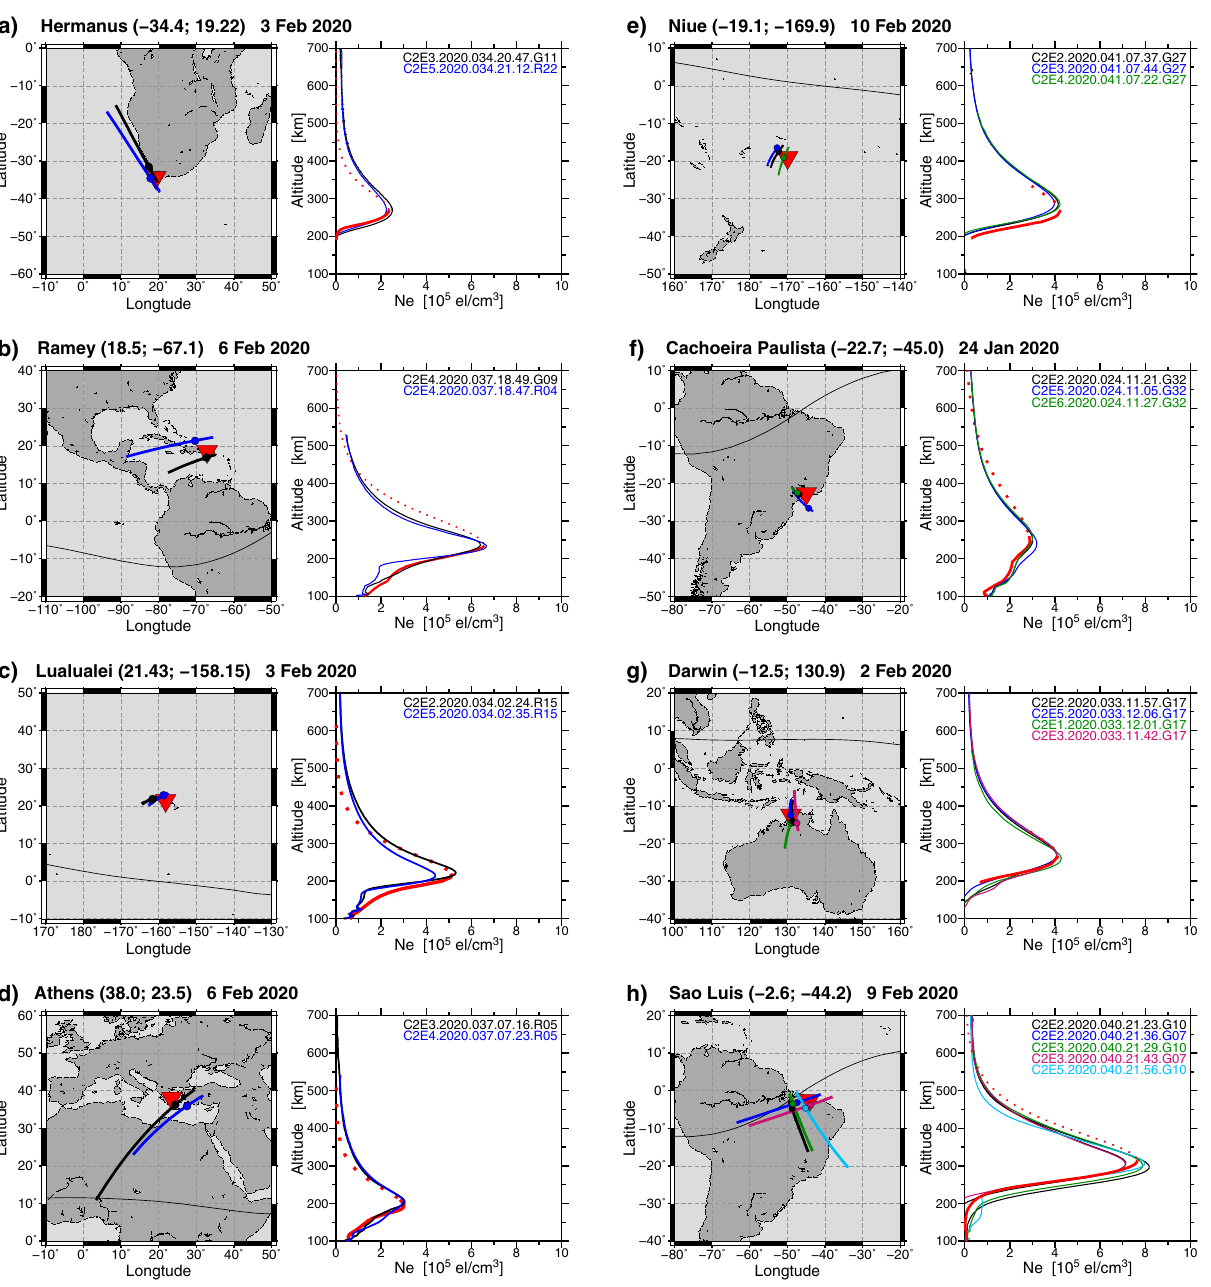
Fig. 2. (a – h) Examples of multiple COSMIC-2 RO electron density pro fi les as compared with collocated ionosondes. For each panel, left plot shows a geographical map with the ionosonde location (red triangle) and RO tangent points projection (small dots show the F2 peak point location on the trace), black line depicts the magnetic equator; right plot shows RO-derived Ne pro fi les and ionosonde-derived Ne pro fi le (solid red line for the measured bottomside part and red dots for modeled topside part of Ne pro fi le). File names like “ C2E3.2020.034.20.47.G11 ” mean COSMIC-2 mission, spacecraft E3, year 2020, day of year 034, time 20:47 UT, “ G ” – tracking GPS satellite PRN 11 (or GLONASS satellite if “ R ”